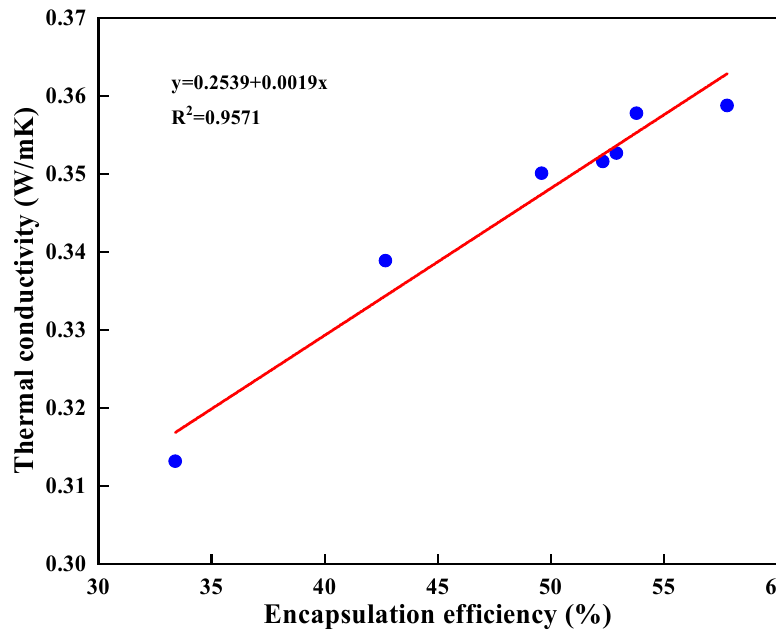
Figure 9. Relationship between encapsulation efficiency and thermal conductivity.